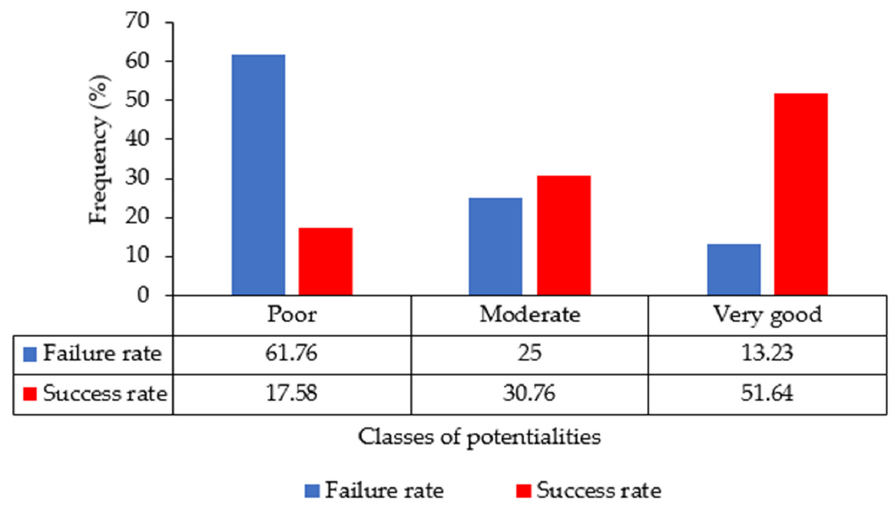
Figure 8. Trend histogram of failure and success rates for each potentiality class.